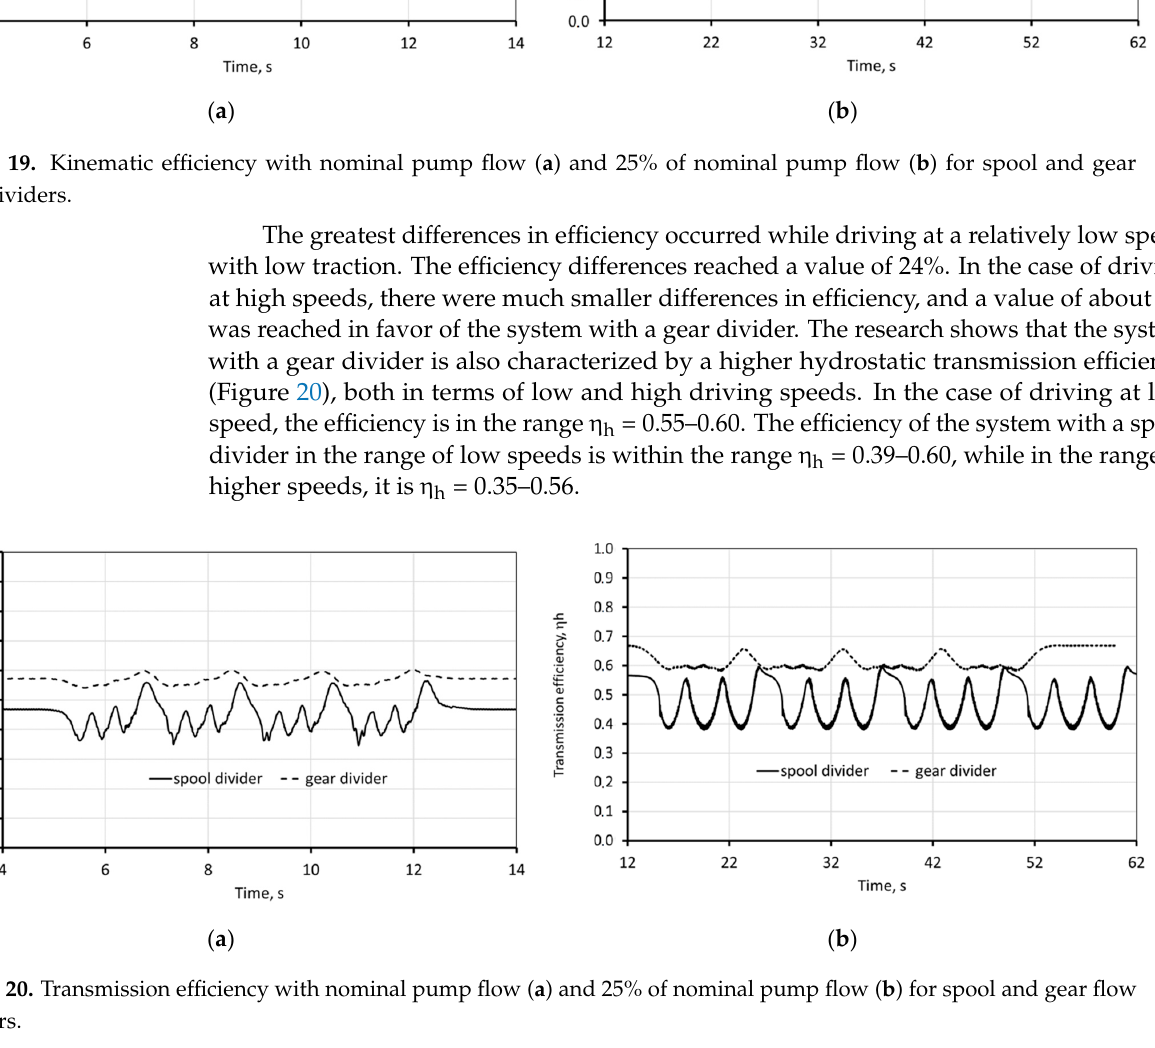
Figure 19. Kinematic efficiency with nominal pump flow ( a ) and 25% of nominal pump flow ( b ) for spool and gear flow dividers.